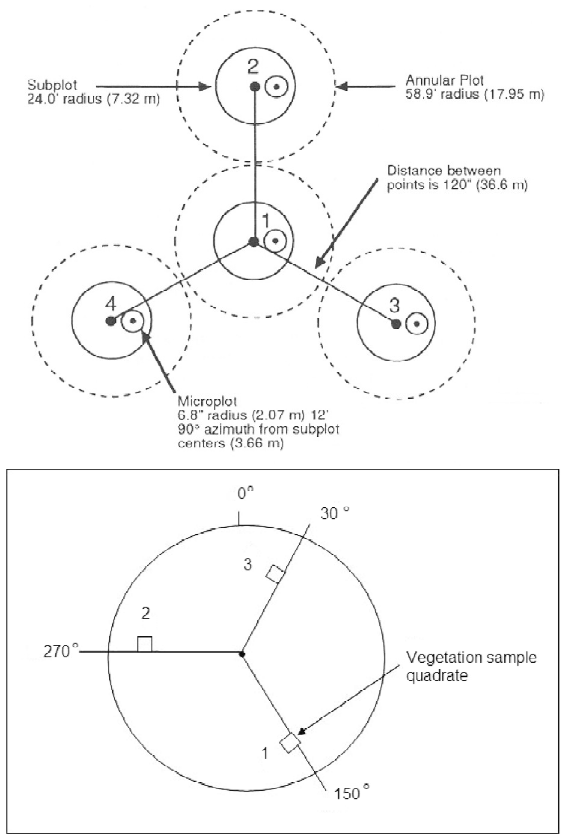
Fig. 2. Scheme of American Forest Health Monitoring study site (top) and location of vegetation sample quadrates (bottom) in vegetation sample microplot (Tallent-Halsell 1994)